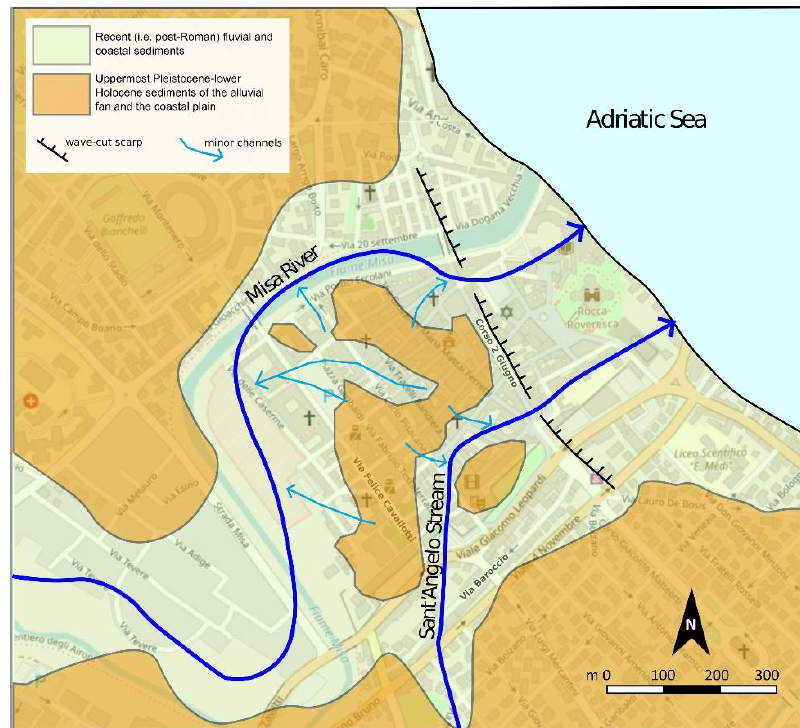
Figure 4. The irregular morphology of the Sena Gallica settlement area as revealed by the Roman “paleosoil” reconstructed by [17]: the unevenness is chiefly related to several gullies that, joining the Misa and Sant’Angelo channels, dissect the apical sector of the fan into mounds and hollows (base map from © OpenStreetMap).